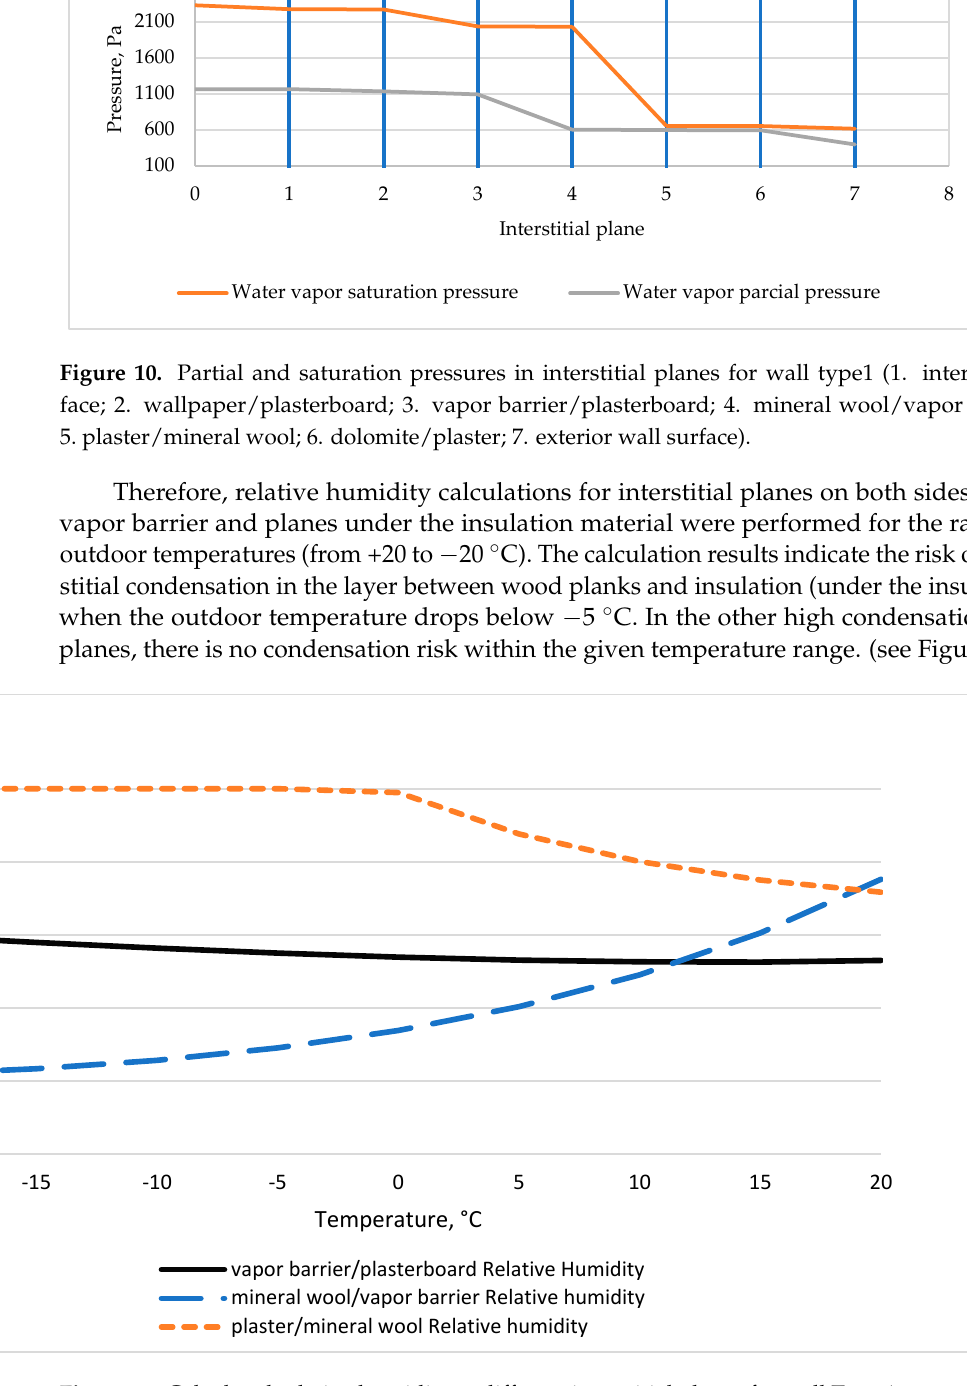
Figure 11. Calculated relative humidity at different interstitial planes for wall Type 1. All three other wall types also did not reach the minimum normative warm/cold side ratio (type 2 = 2.85; type 3 = 3.78; type 4 = 1.74); therefore, the saturated and partial pressure calculation for all planes of all wall types was performed. As for wall type 1 and all the other wall types, the interstitial planes under the insulation material were found to be most prone to condensation. Therefore, the same relative humidity calculations for wall type 1 were performed for all the other wall types. The results for all the other wall types were very similar to those for wall type 1, with condensation risk under the insulation